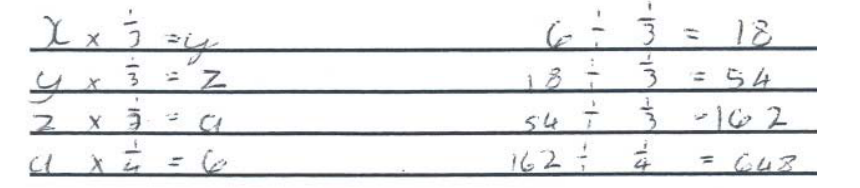
Figure 4: Group 4’s results for problem